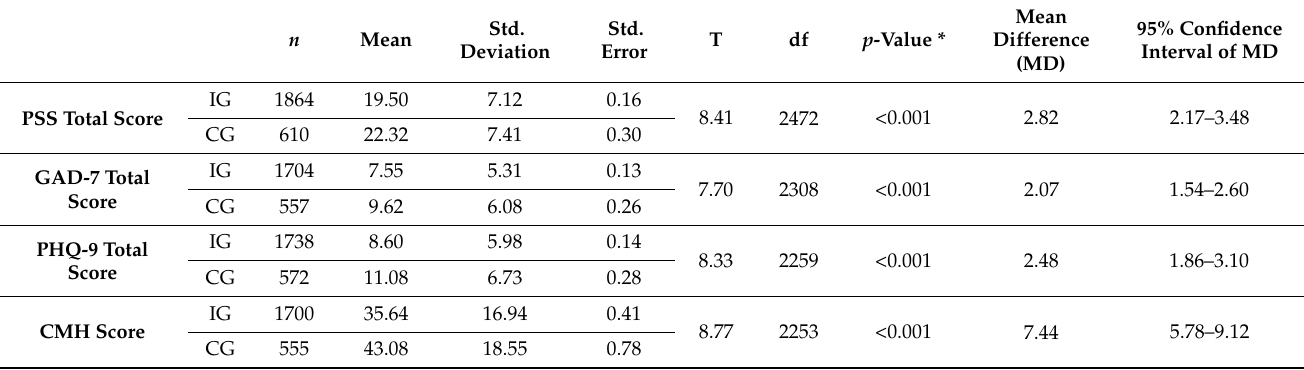
Table 2. Independent sample t -test comparing the mean scores for IG and CG on the Perceived Stress Scale (PSS), the Generalized Anxiety Disorder 7-item (GAD-7), and Patient Health Questionnaire-9 (PHQ-9) scales and the Composite Mental Health (CMH) score.